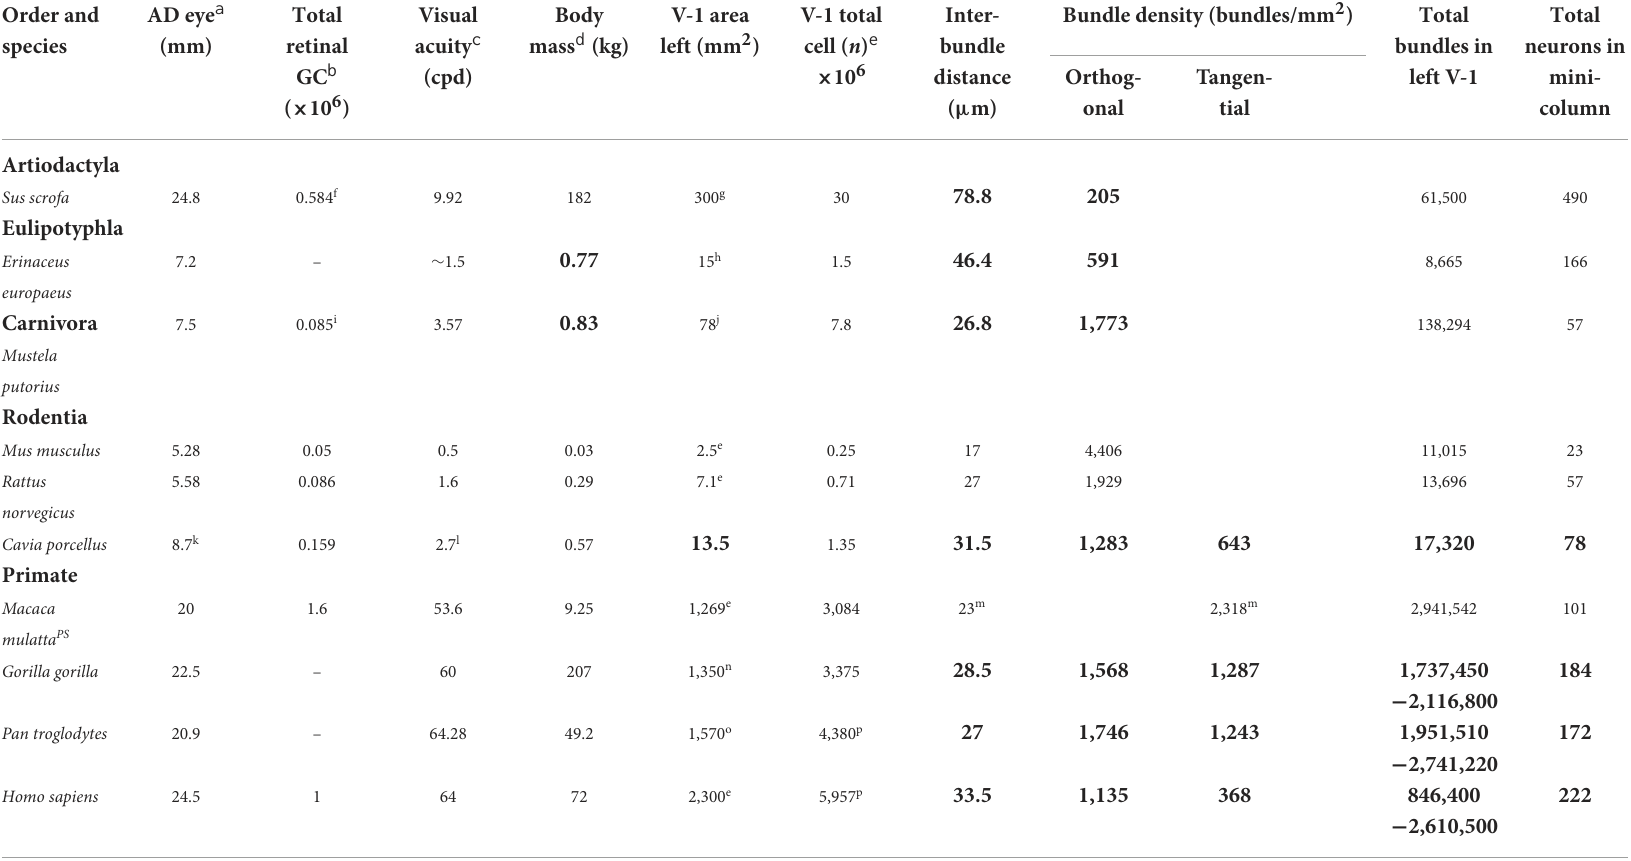
Boldfiguresweremeasuredinthecurrentstudy.Othervalueswereobtainedfrompublisheddataasindicatedbythesuperscriptnumbers.Columntitlesareabbreviatedasfollows:AD,axialdiameter;retinalGC,retinalganglioncells(inmillions).Visual